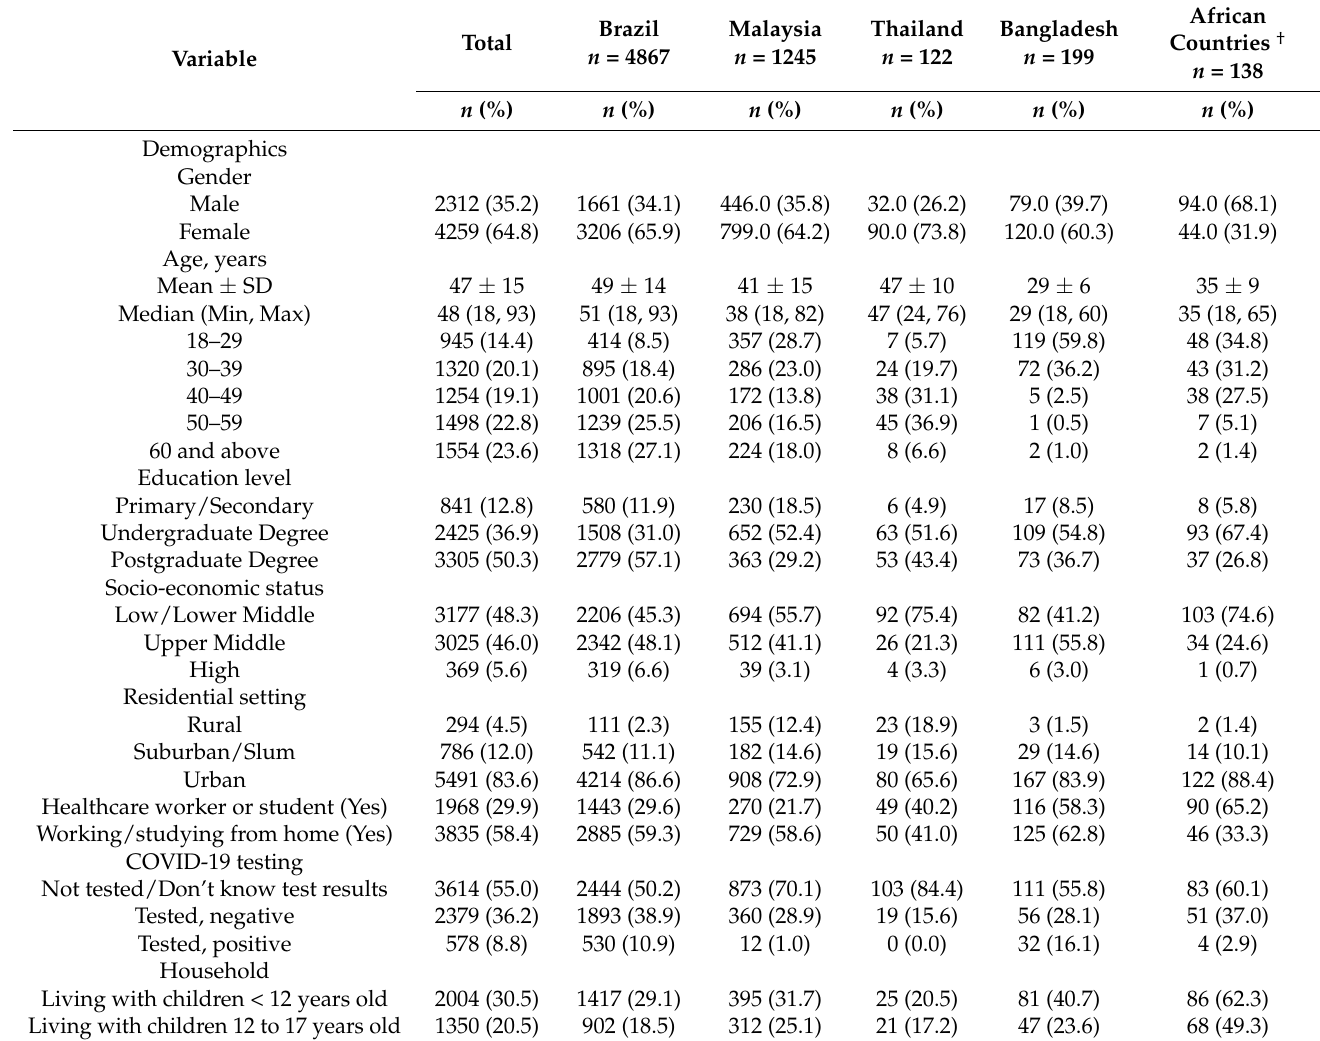
Table 1. Participants’ demographics and health status ( n =